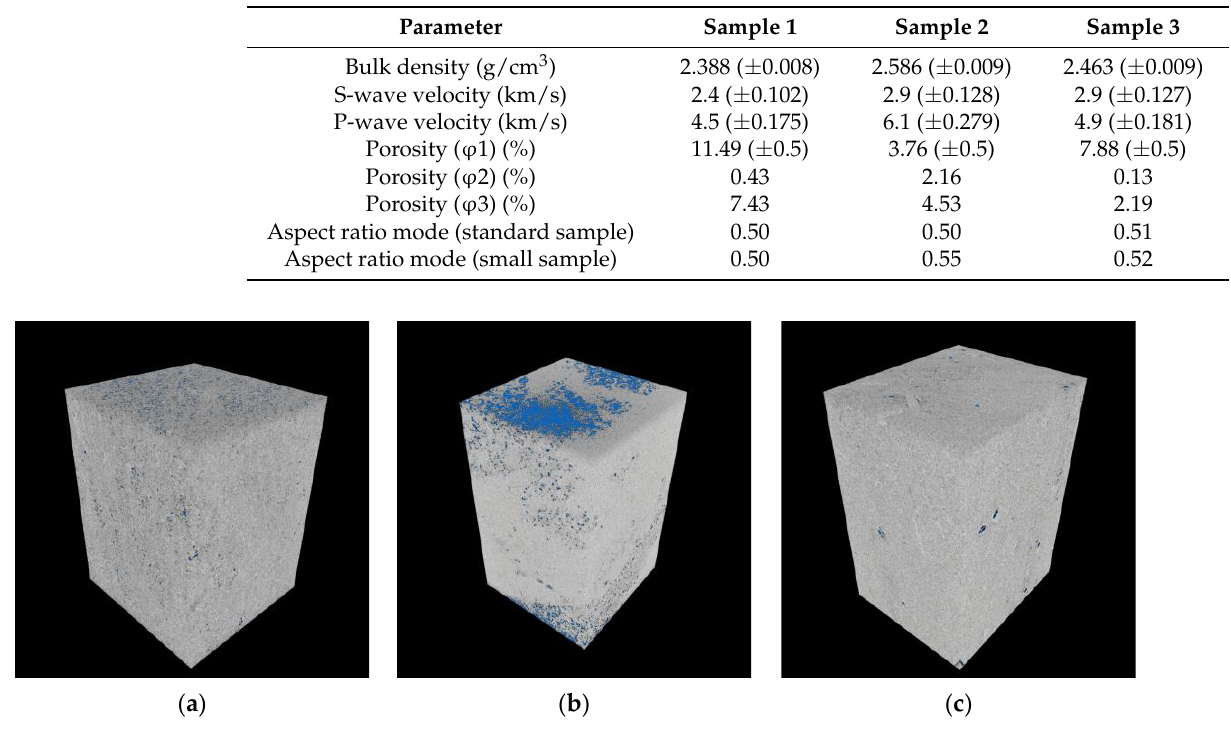
Figure 5. Volumetric model of ( a ) Samples 1, ( b ) Sample 2, and ( c ) Sample 3 with a diameter of 30 mm according to the results of Computed Tomography. Pores are marked in blue.